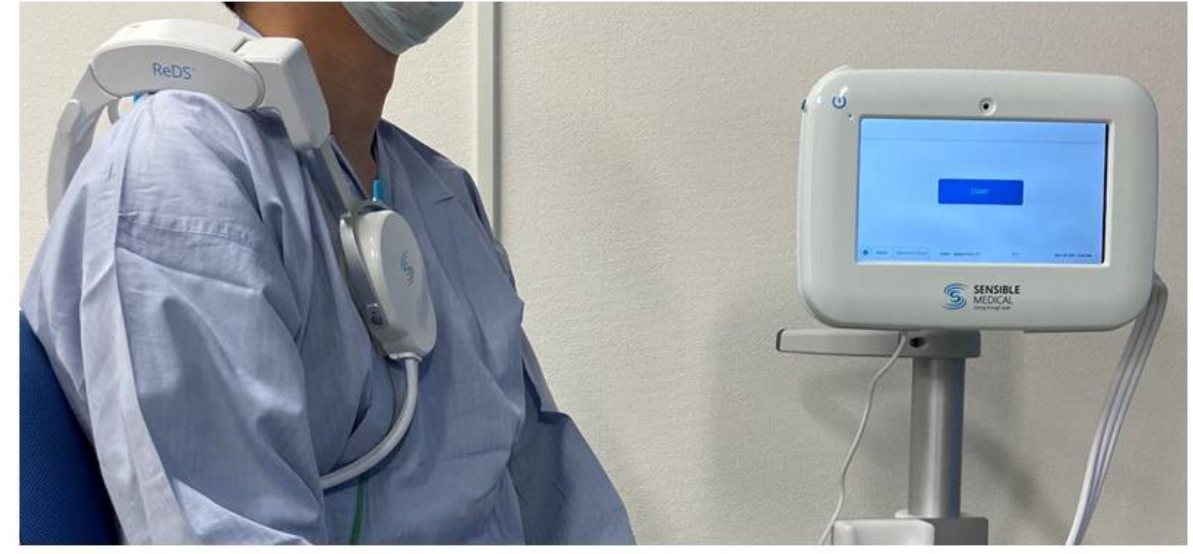
Figure 1. ReDS system. ReDS, remote dielectric sensing.